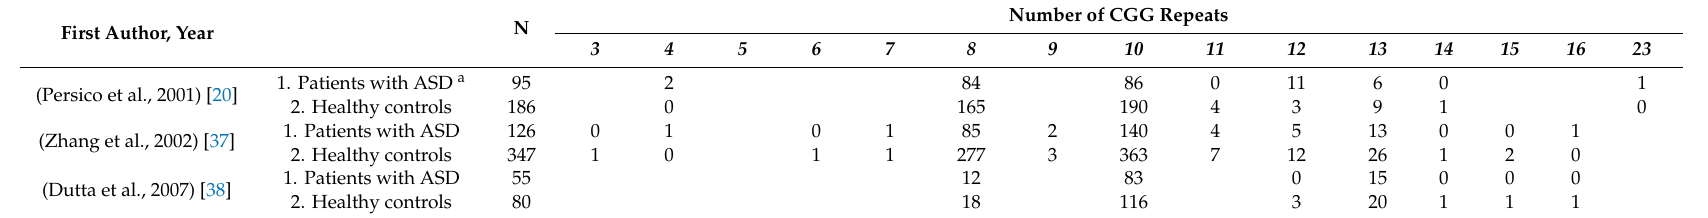
Table 2. Distribution of RELN CGG repeat